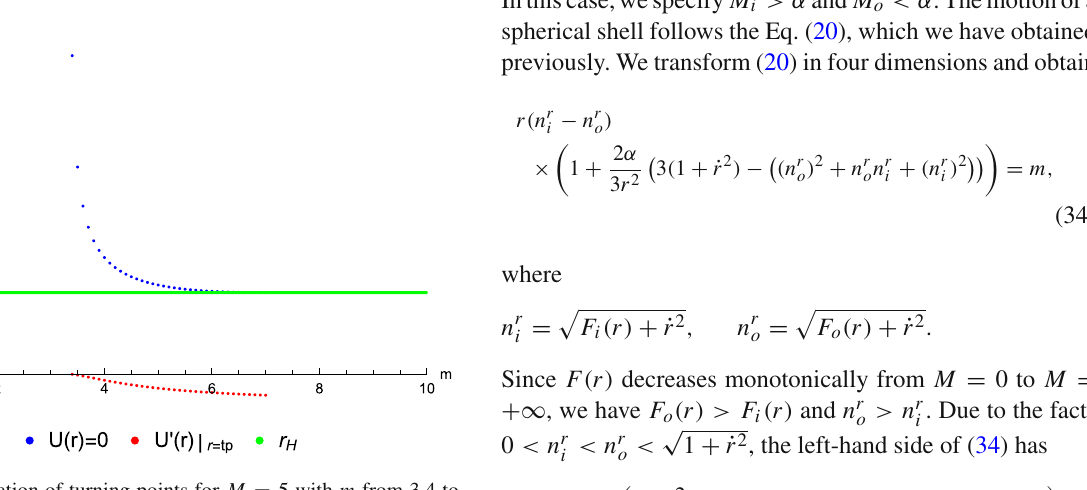
Fig. 4 The location of turning points for M = 5 with m from 3.4 to 7 with (cid:16) m = 0 . 1 is plotted. Note that U (cid:10) ( r ) | r = tp only has numerical meaning in the vertical